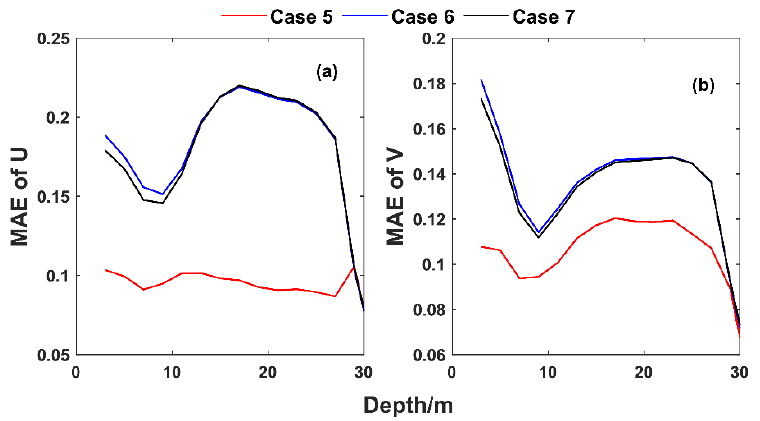
Figure 13. The MAEs between inverted currents and observed currents in Cases 5, 6, and 7. Subplots ( a ) and ( b ) correspond to the horizontal velocity components U and V, respectively.